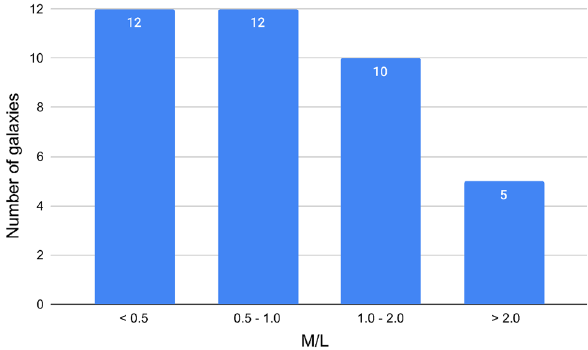
Fig. 12 Distributionofthemass-to-lightratiovalues ϒ d forthediskfor the set of the 27 considered bulgeless galaxies with a fixed R = 16 kpc